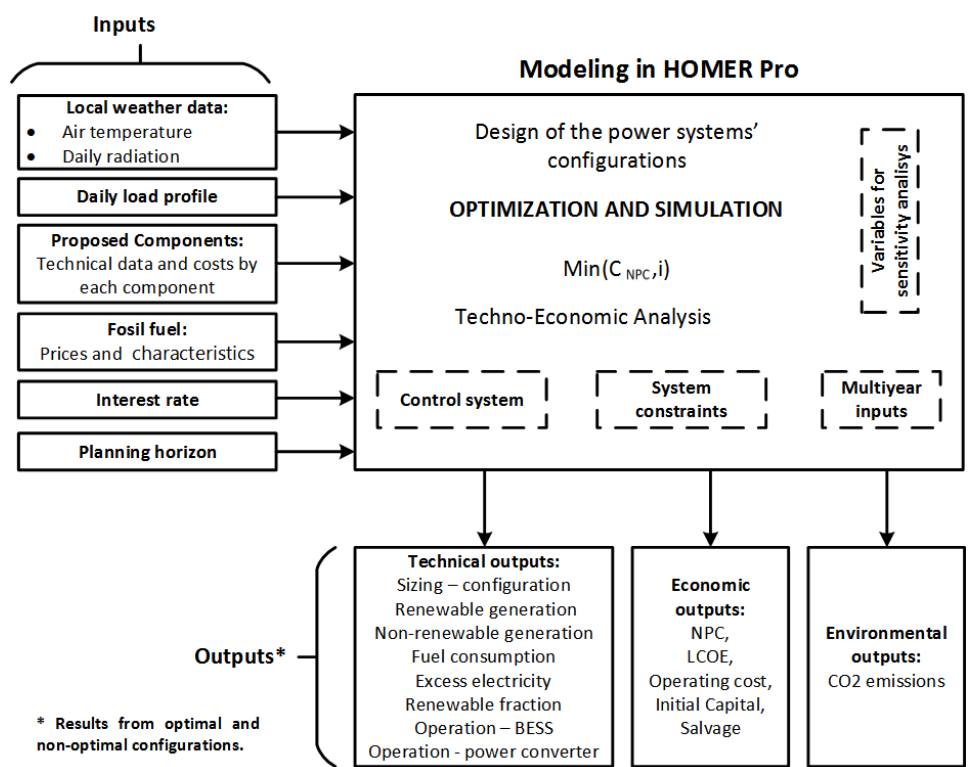
Figure 1. Methodological steps used for evaluating off-grid hybrid power